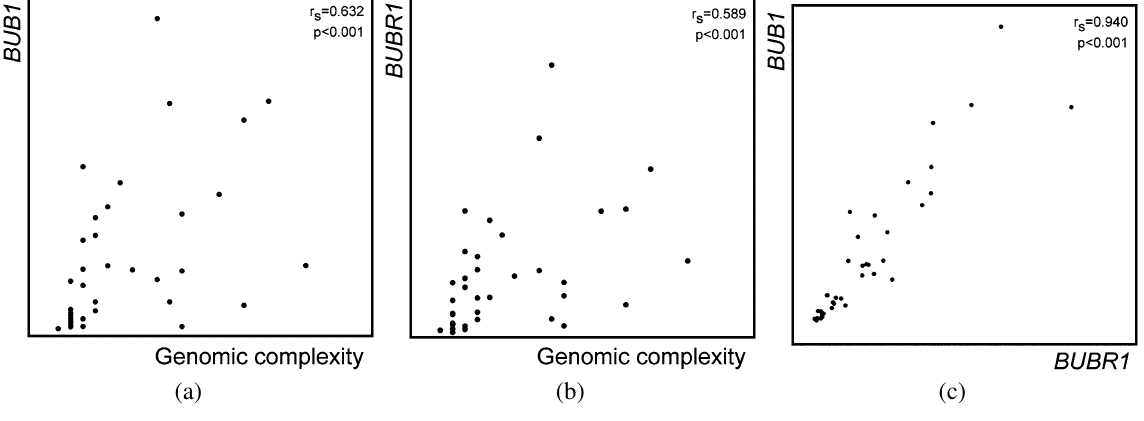
Fig. 2. Correlation between relative expression levels of BUB1 (a) and BUBR1 (b) with genomic complexity, and between each other (c). Abbreviations: r s – Spearman’s correlation coefficient.